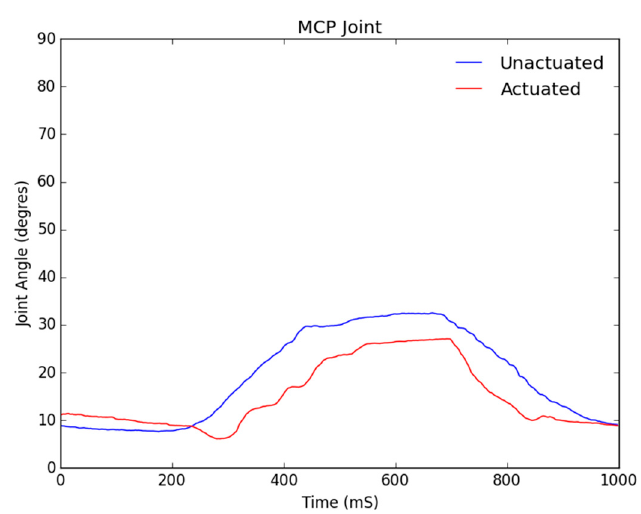
Figure 11. Motion analysis data for the metacarpophalangeal (MCP) joint.